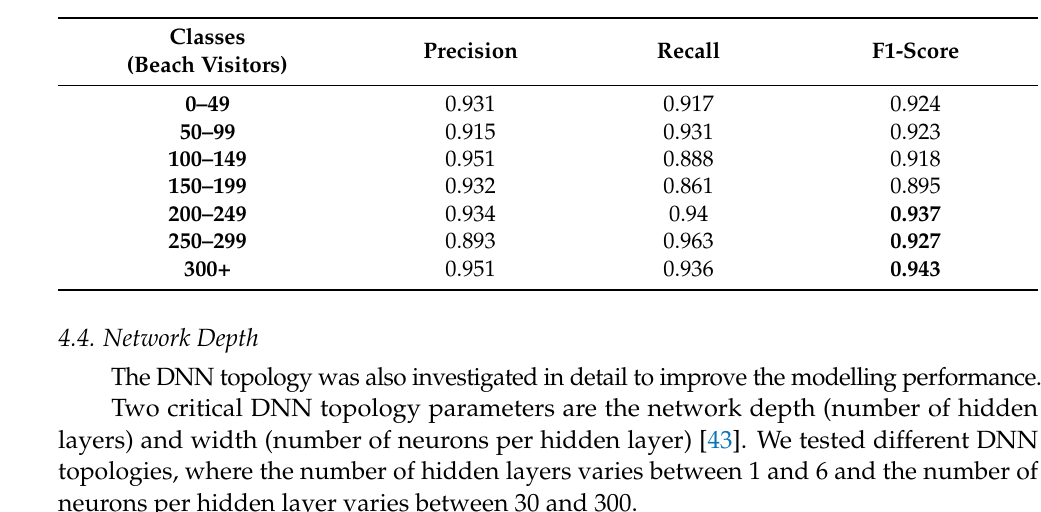
Table 9. Per-class precision, recall, and F1-scores for the time period